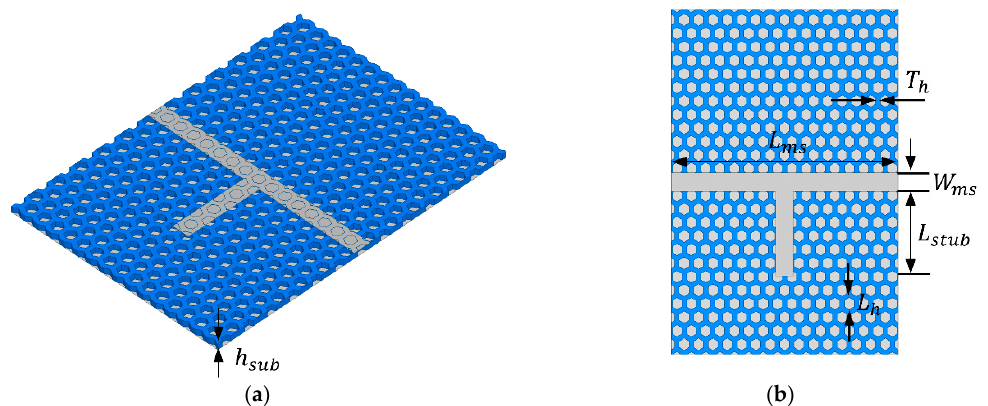
Figure 4. Layout of simulated T ‐ resonator: ( a ) perspective and ( b ) top view.